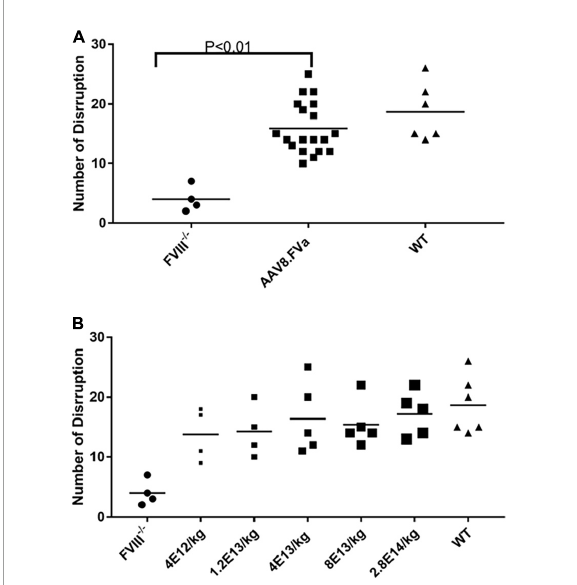
FIGURE4 In vivo hemostasis improvement by saphenous vein bleeding assay (SABV) in hemophilia A mice treated with AAV8/hFVa. Five different doses of AAV8/hFVa vectors, from 4 × 10 12 to 2.8 × 10 14 vg/kg ( N = 19 for AAV8/hFVa treated), were given to FVIII - / - mice. At 12–20 weeks after AAV8/hFVa administration, SVBA was performed. The number of disruptions within 30 min was recorded. (A) A number of disruptions from five different doses of AAV8/hFVa were pooled together. (B) Number of disruptions from individual groups with different doses of AAV8/hFVa ( N =